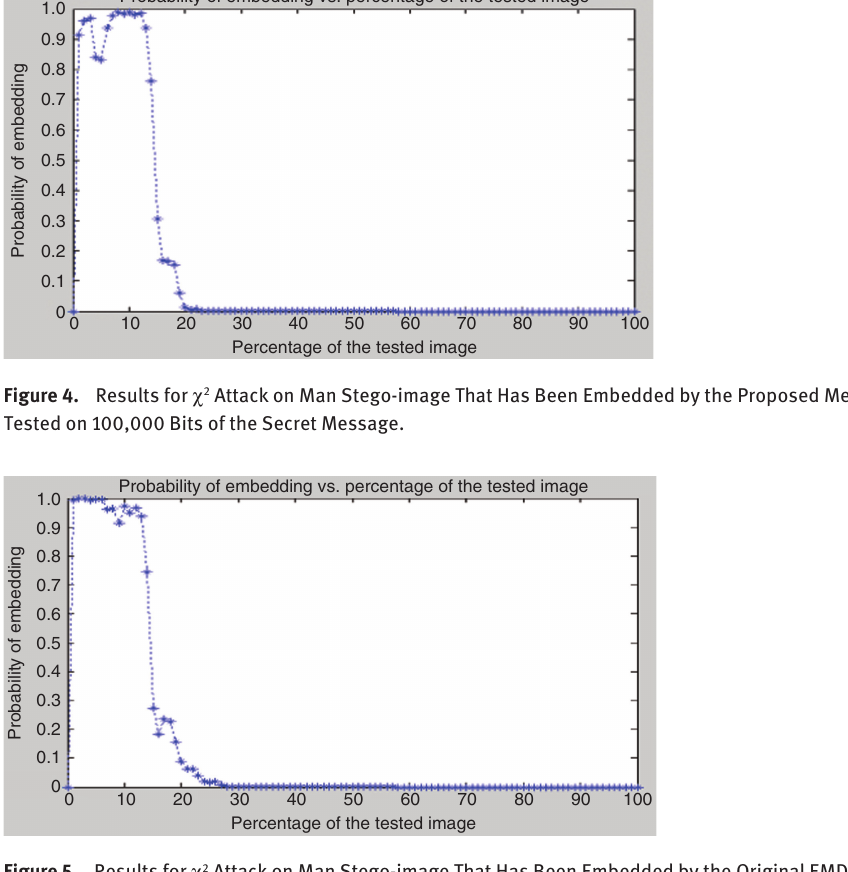
Figure 5. Results for χ 2 Attack on Man Stego-image That Has Been Embedded by the Original EMD Method Using 2-Pixel Group and Tested on 100,000 Bits of the Secret